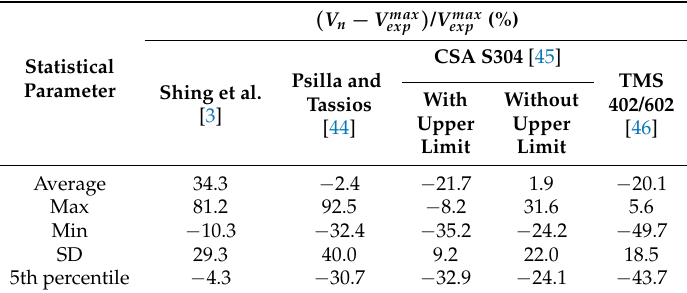
Table 7. Statistical parameters of prediction